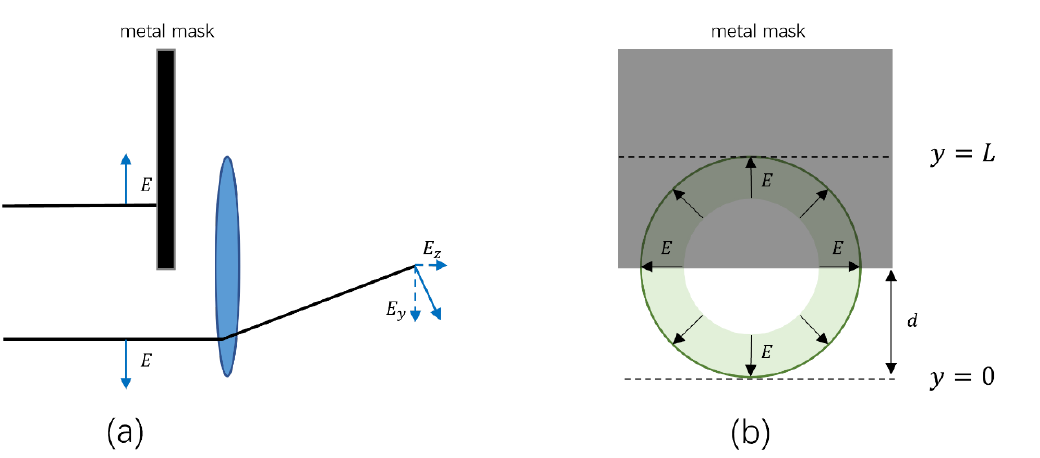
Figure 1. The directions of the electric fields at the focal plane originating from ( a ) radially polarized THz waves, and ( b ) linearly polarized THz waves.